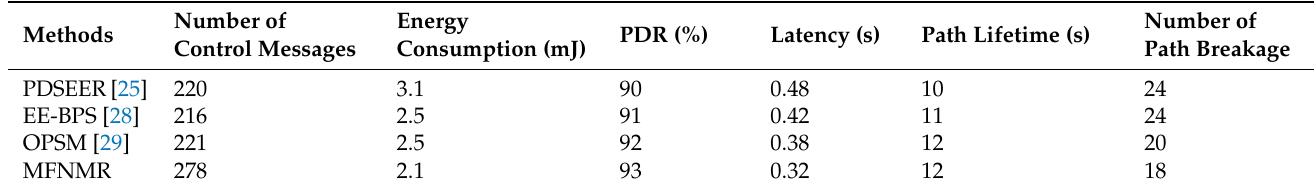
Table 4. Performance analysis of PDSEER, EE-BPS, OPSM and